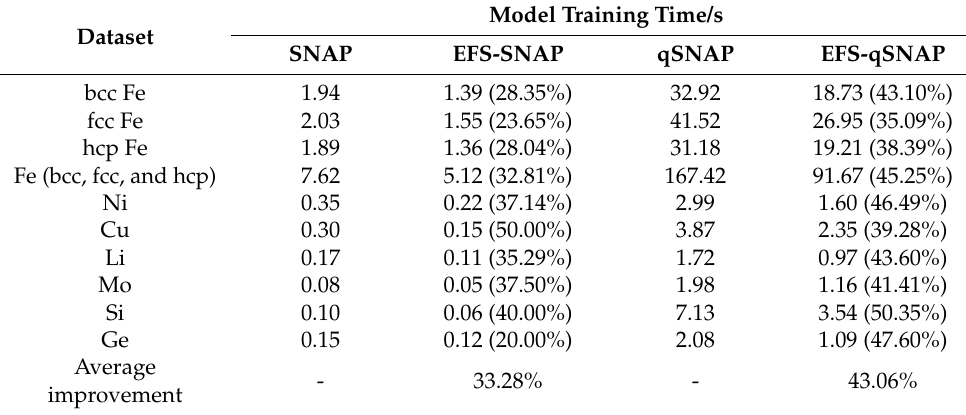
Table 9. Computational complexity comparison between qSNAP and EFS-qSNAP.